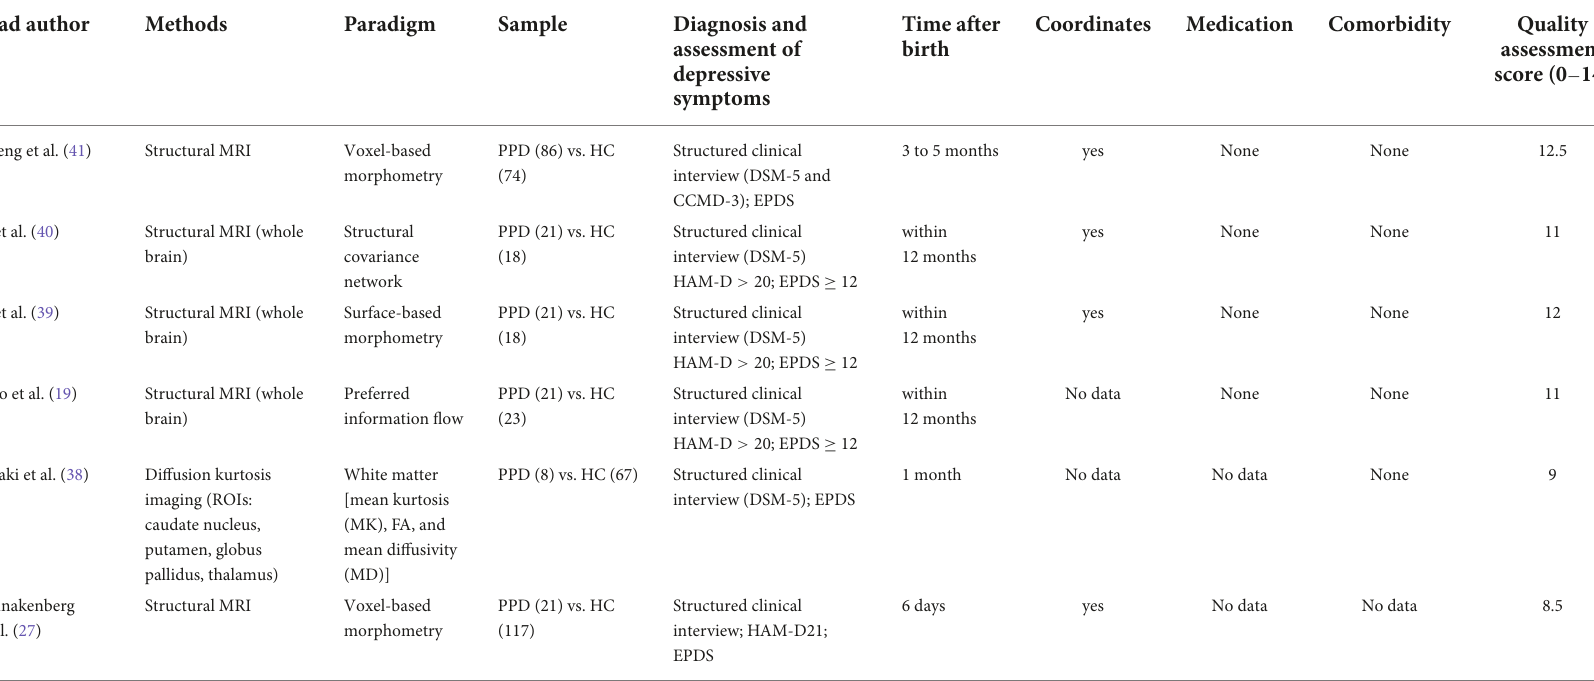
TABLE 2 Data extraction of structural magnetic resonance